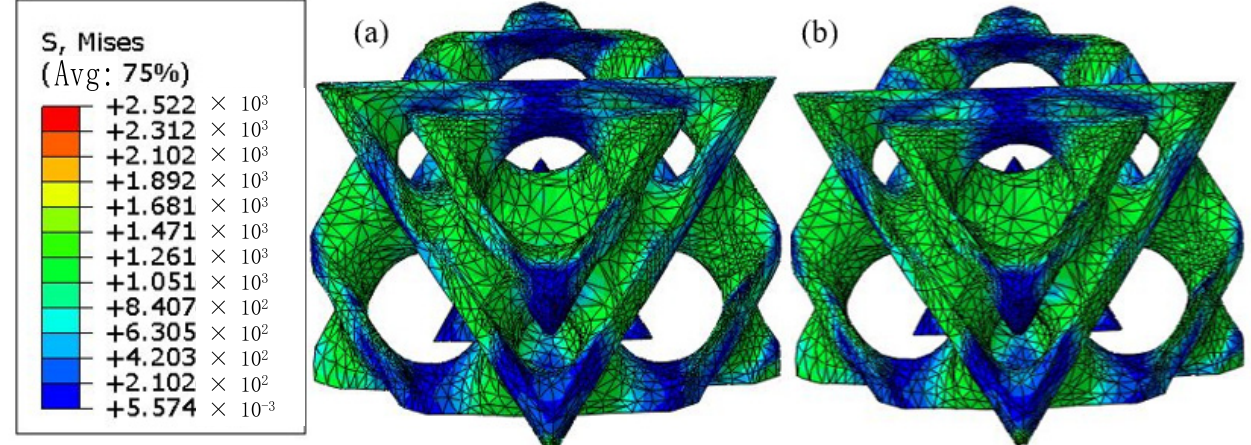
Figure 7. Quasi-static compression simulation results of the D structure: ( a ) stress distribution without considering void defects, ( b ) stress distribution considering void defects.